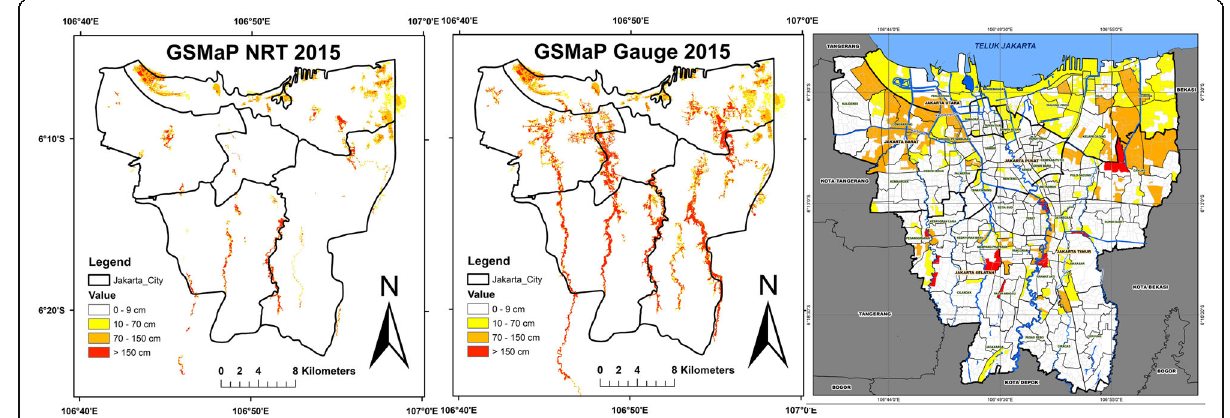
Fig. 12 Flood Inundation comparisons for flood event of